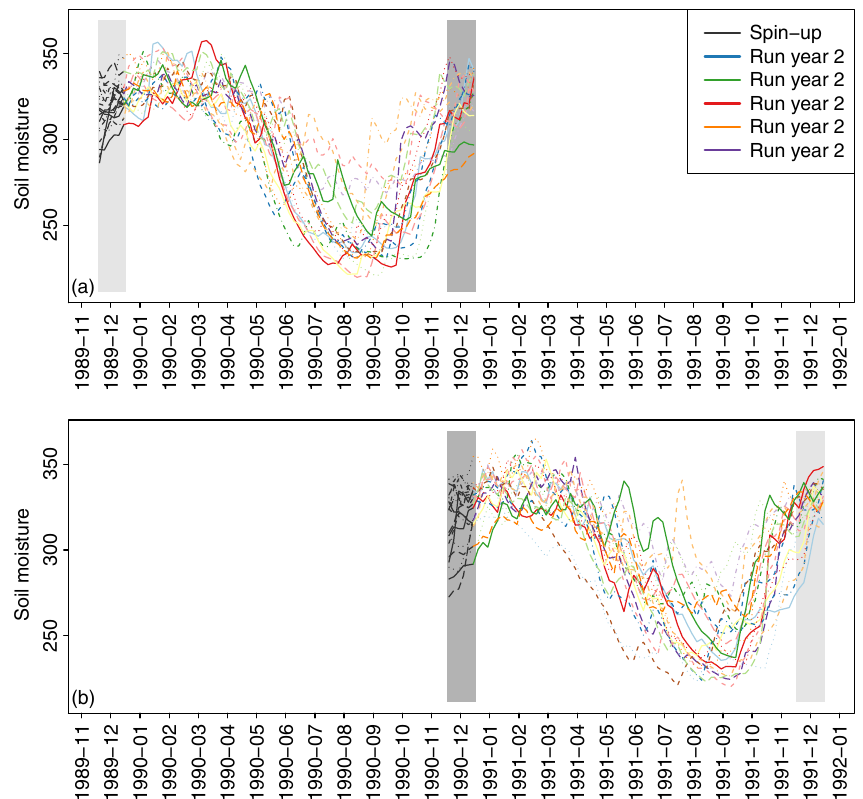
Figure 1. Illustration of the simulation design and stitching, using soil moisture model data averaged over the Thames catchment. Each panel shows, for a given year ( a : 1990; b : 1991), 5-day averages of soil moisture in the upper 1m of the soil for 20 model simulations. The first month of the simulations (December of the previous year, part of the spin-up) is indicated by grey lines, followed by the 12 months (January to December) in colours. End-of-year values of 1990 simulations and the same time steps in the spin-up leading to 1991 values, highlighted by dark grey boxes, have to be compared to find the combination allowing the best match between simulations. Light grey boxes indicate the same time steps that will be used to stitch to 1989 (a) and 1992 (b)